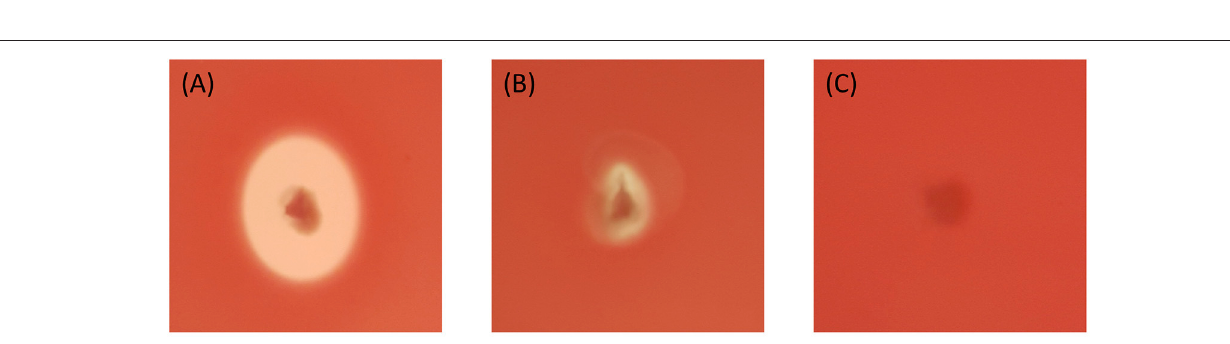
FIGURE 4 | Different types of the hemolytic activities shown by Bt isolates. (A) Positive hemolytic activity QBT229 (B) Slight hemolytic activity QBT43 (C) Negative hemolytic activity